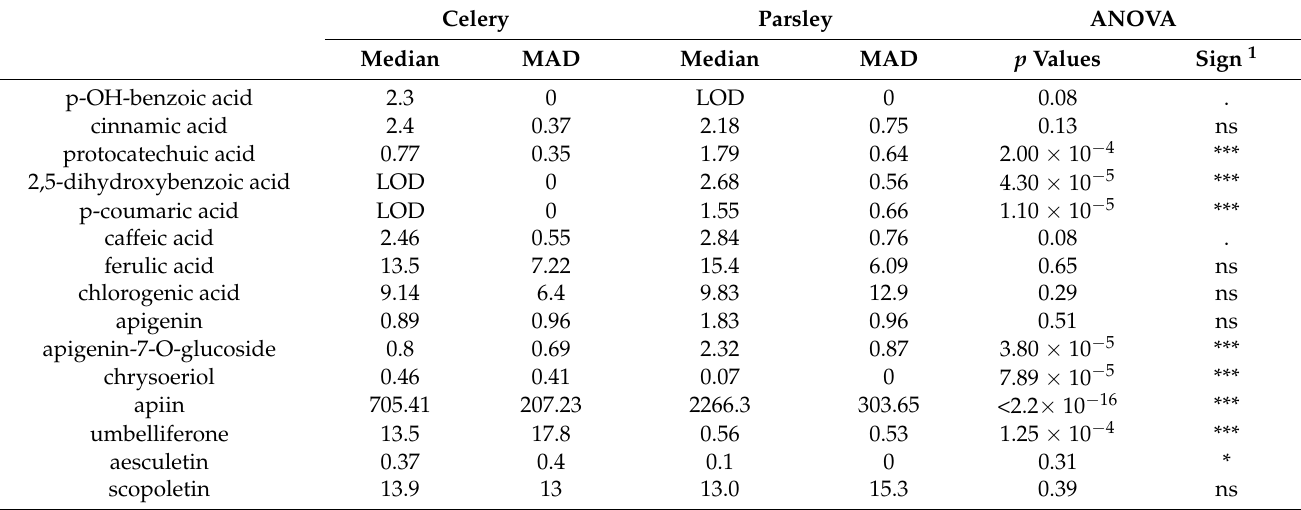
aesculetin 0.37 scopoletin Data are presented as the median ± the mean absolute standard deviation (MAD), ( n = 21). One-way ANOVA was used for comparison of the means between species. 1 Signif. codes: 0 ‘***’ 0.001 ‘*’ 0.05 ‘.’ 0.1 ‘ns’ 1. LOD—values lower than limit of detection. The following metabolites were lower than the limit of detection in all analyzed samples: o-coumaric acid, vanillic acid, gallic acid, syringic acid, 3,4-dimethoxycinnamic acid, synapic acid, daidzein, genistein, kaempferol, luteolin 7-O-glucoside, catechin, epicatechin, quercetin, isorhamnetin, myricetin, matairesinol, secoisolariciresinol, vitexin, baicalin, quercitrin, kaempferol-3-O-glucoside, epigallocatechin gallate, hiperoside, amentoflavone, rutin, quercetin-3-O-glucoside, baicalein, luteolin, naringenin. The given results are used for Standardized Major Axis (SMA) regression, which is an often utilized model since it can provide true information between two factors, assuming variation in both variables [17]. In the TEs data set, the majority of variance was weighted in the first two components explaining 65.5% in the overall variability, where PC1 contributed 38.2%, separating Cr from the rest of the TEs, which dominated in parsley (Figure 4). Therefore, for SMA, we used PC1 as a functional gradient, since it was a major axis explaining TEs variability and was sufficient to describe the essence of the data. Based on the PCA biplots of phenolics, flavonoids, and coumarins, we observed that the first two principal components explained 71.1% of the total variance in phenol acids, 90.4% in flavonoids, and 84.8% in the coumarins data set (Figure 4). Depending on the loadings of variables clustering across the biplot, we selected two compounds per group (phenolic acids, flavonoids, and coumarins) as factors used for SMA (Figure